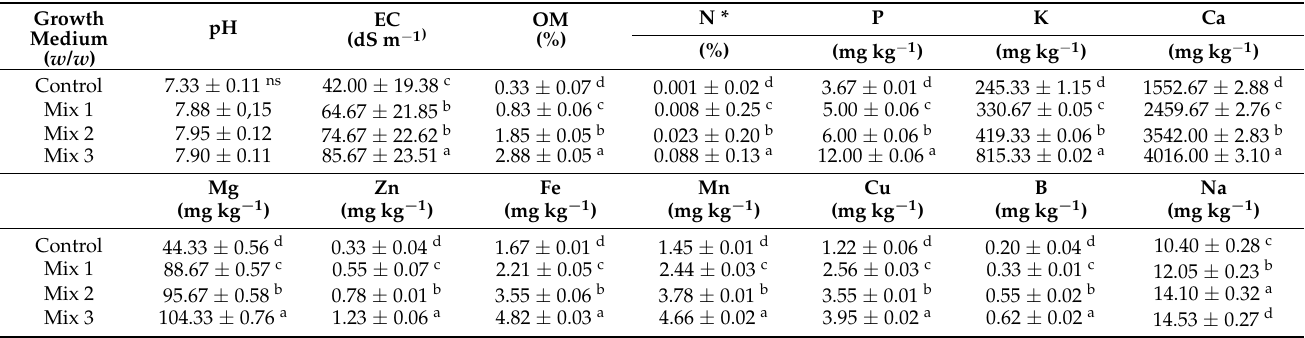
Table 3. Effects of vermicompost application on growth medium chemical